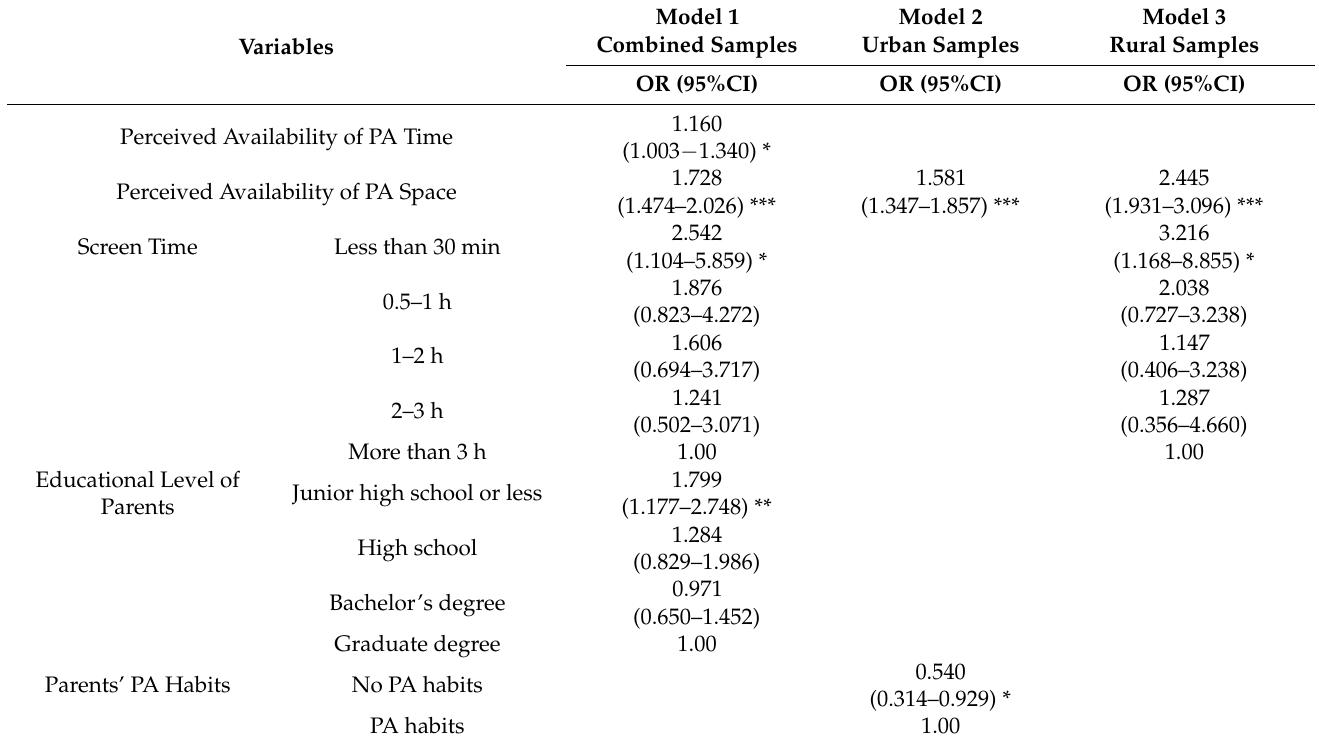
Table 7. Variables Predicting VPA frequency: Results from Ordinal Logistic Regression